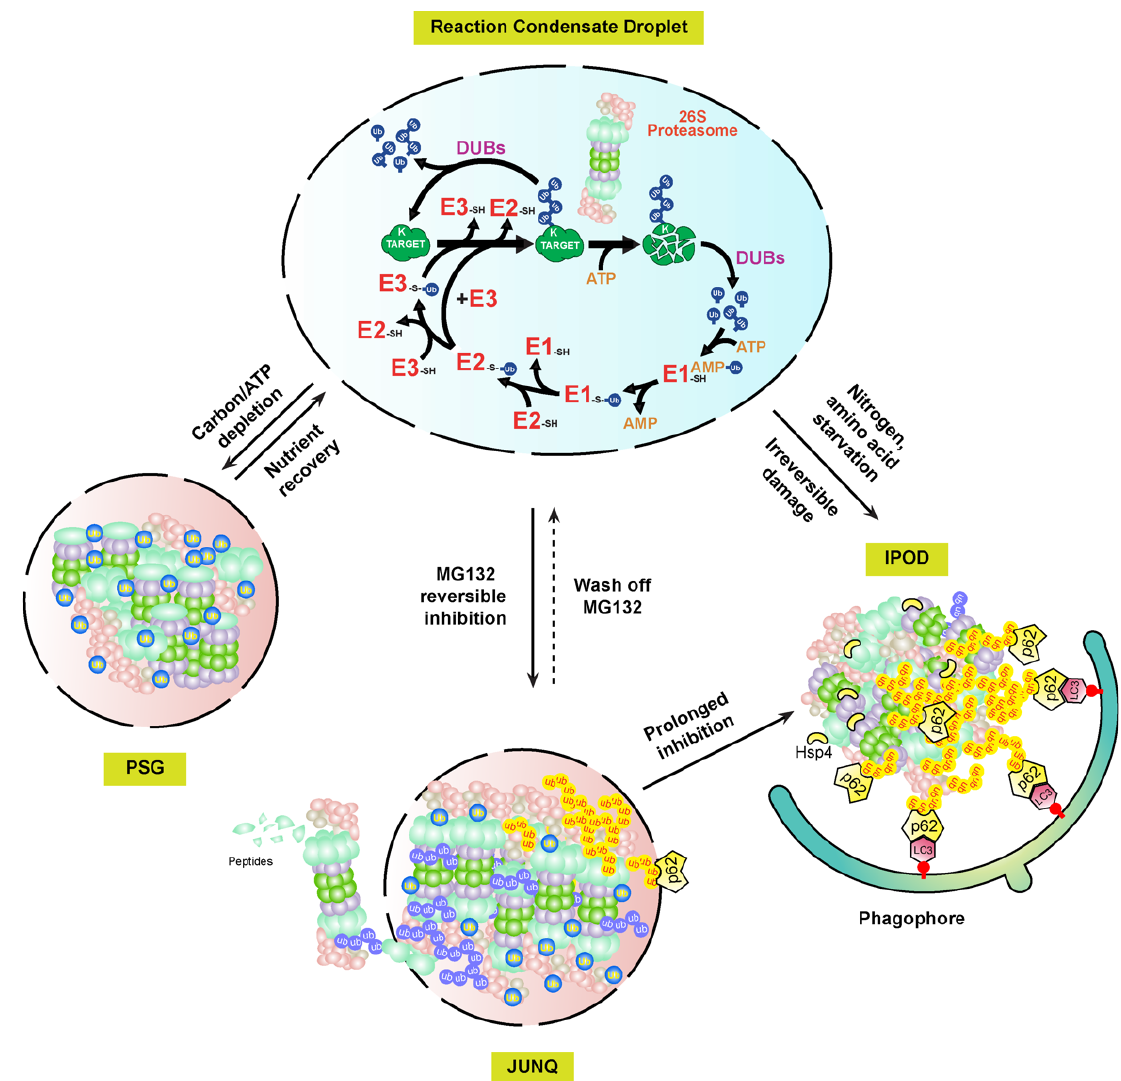
Figure 3. A biophysical dynamic module of intracellular proteasomes with different functional activities and stabilities. In normal cellular growth conditions, the UPS and its substrates may develop concentrated liquid droplets through LLPS for efficient proteolysis of ubiquitylation substrates [127]. Upon different stresses, the soluble proteasomes may either form PSG or JUNQ condensates, depending on whether the RP and CP subcomplexes are dissociated in yet unknown mechanisms [108,124]. The substances, including damaged proteasomes, in the highly fluidic JUNQ body are still under active ubiquitylation reactions. Ubiquitylated proteasome subunits may be extracted out